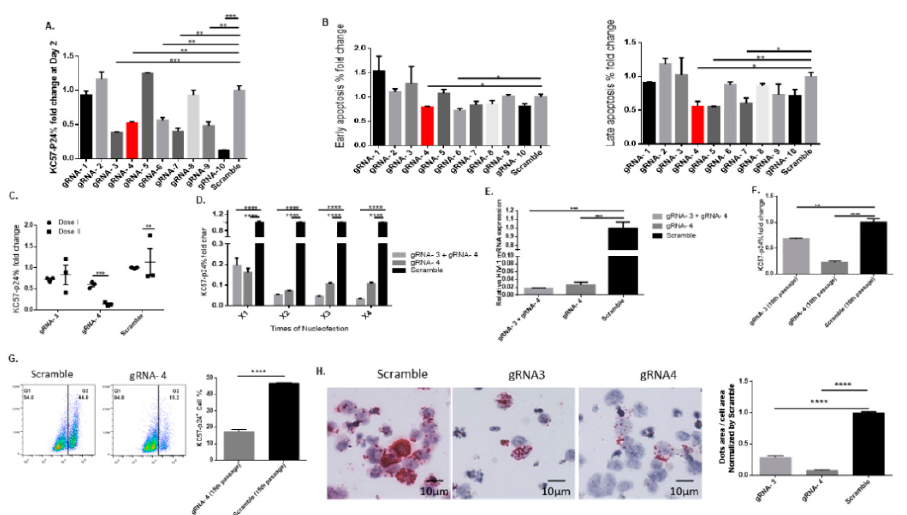
Figure 3. Treatment with gRNA-3 or gRNA-4 RNP inhibits HIV infection. ( A ) HIV p24 expression levels in highly permissible SupT1 cells 48 h after incubation with supernatants of J1.1 cells transfected with various gRNA/Cas9 RNPs for 48 h, normalized to the scramble control. ** p < 0.01, *** p < 0.001. ( B ) Early and late apoptotic SupT1 cells infected by the supernatants of J1.1 cells transfected by various gRNA/Cas9 RNPs for 48 h, normalized to the scramble control. * p < 0.05, ** p < 0.01. ( C ) HIV p24 expression in J1.1 cells transfected with one dose of gRNA-3 or gRNA-4 RNP (dose I, round symbol). Then, the cells were sorted and transfected with a second dose gRNA-3 or gRNA- 4 RNP for 48 h (dose II, square symbol), normalized to the scramble control. *** p < 0.001. ( D ) HIV-1 p24 expression after a dose-dependent (X1, X2, X3, X4) RNP treatment/transfection of J1.1 cells for 1, 5, 10, and 20 days with combined (gRNA-3 + gRNA-4) or single gRNAs (gRNA-4 or Scramble). **** p < 0.0001. ( E ) . HIV-1 mRNA levels in total RNA isolated after four doses of nucleofection. ( F ) HIV p24 expression in J1.1 cells transfected with gRNA-3 or gRNA-4 RNP and maintained for 10 passages, normalized to the scramble control. ** p < 0.01, **** p < 0.0001. ( G ) HIV p24 expression in J1.1 cells transfected with the gRNA-4 RNP and maintained for 15 passages, normalized to the scramble control. **** p < 0.0001. ( H ) HIV-1 RNA levels in J1.1 cells transfected with gRNA-3 or gRNA-4 RNP, assessed by RNAscope. Representative RNAscope imaging (left) and summary data (right) were analyzed by QuPath software (bundled with 64-bit Java 1.8.0_172) and GraphPad Prism (Version 6.01) to quantify the positive HIV RNA dots in 6 imaging areas, normalized to the scramble control. **** p < 0.0001.